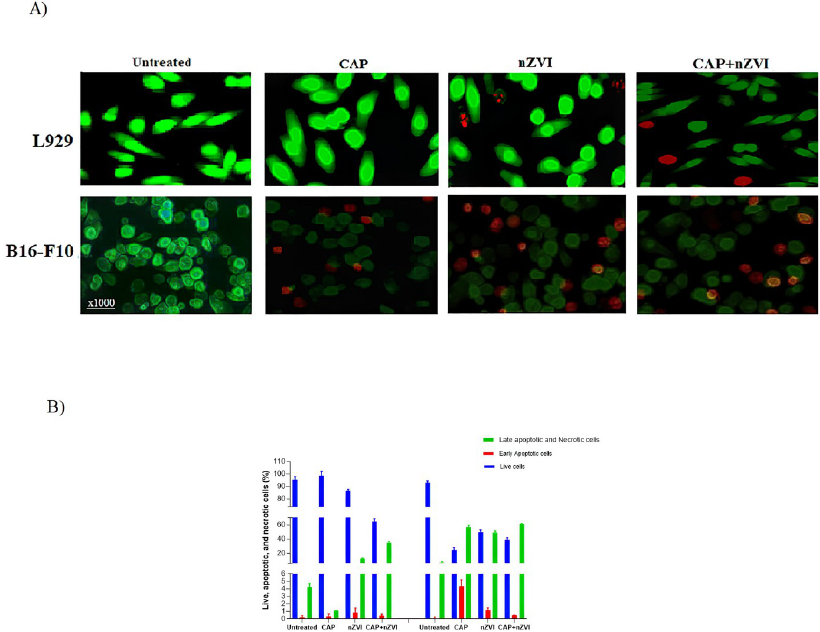
Fig 4. Apoptosis detection in B16-F10 cancer and L929 normal cells under treatment of CAP, nZVI, and combination of CAP and nZVI. A) The pattern of AO/ EtBr staining of B16-F10 cancer cell line and L929 normal cells treated using CAP, nZVI, and combination treatment. Viable cells are green in color while dead cells are red. B) Annexin V/PI flow cytometry analysis of the B16-F10 and L929 cells after harvesting by trypsinization. The graph represents the percentage of live cells, early and late apoptosis, and